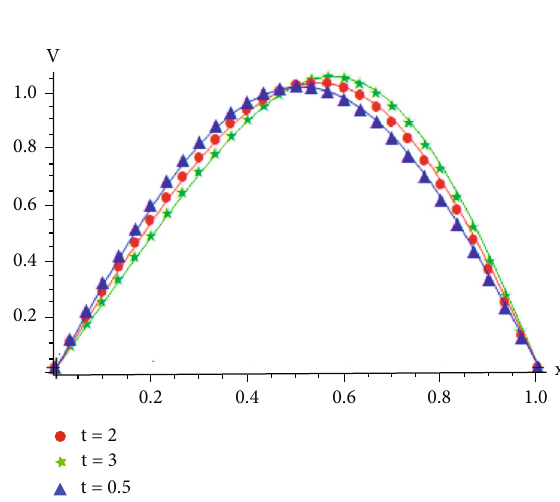
Figure 1: The exact and approximate (triangles, starts, circles) solutions for Example 5 at various times when h = 0 : 01